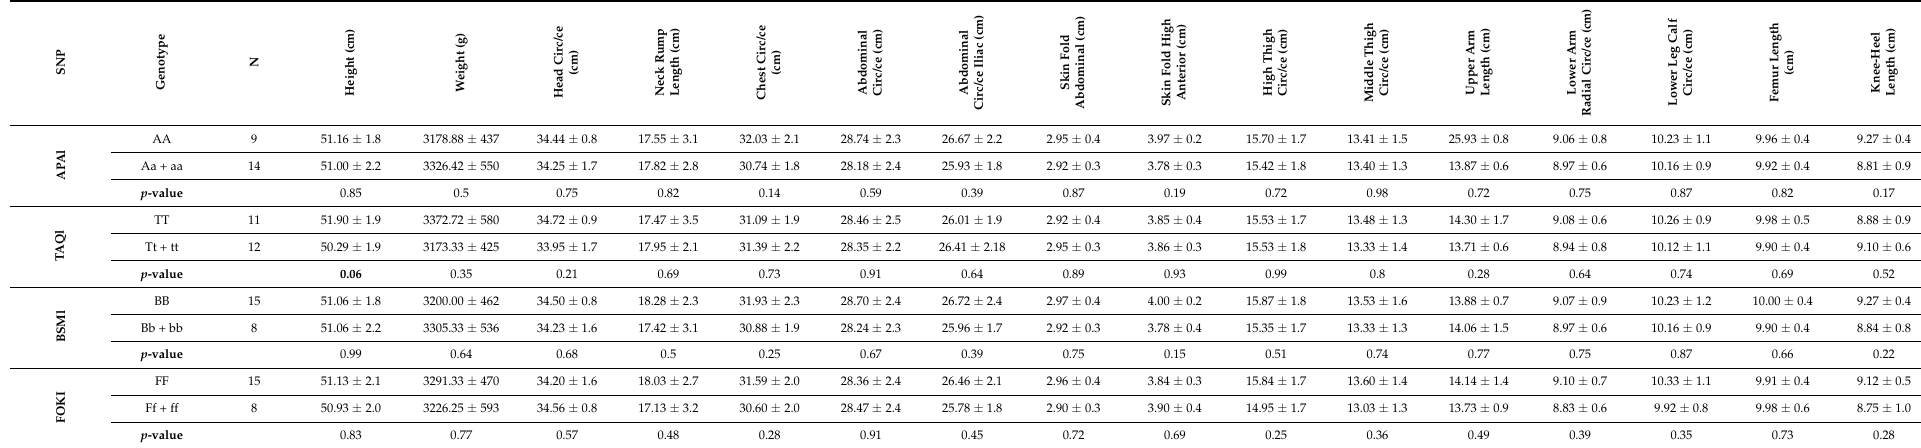
Table 7. Birth neonatal anthropometry (maternal vitamin D status at birth >50 nmol/L) according to maternal VDR